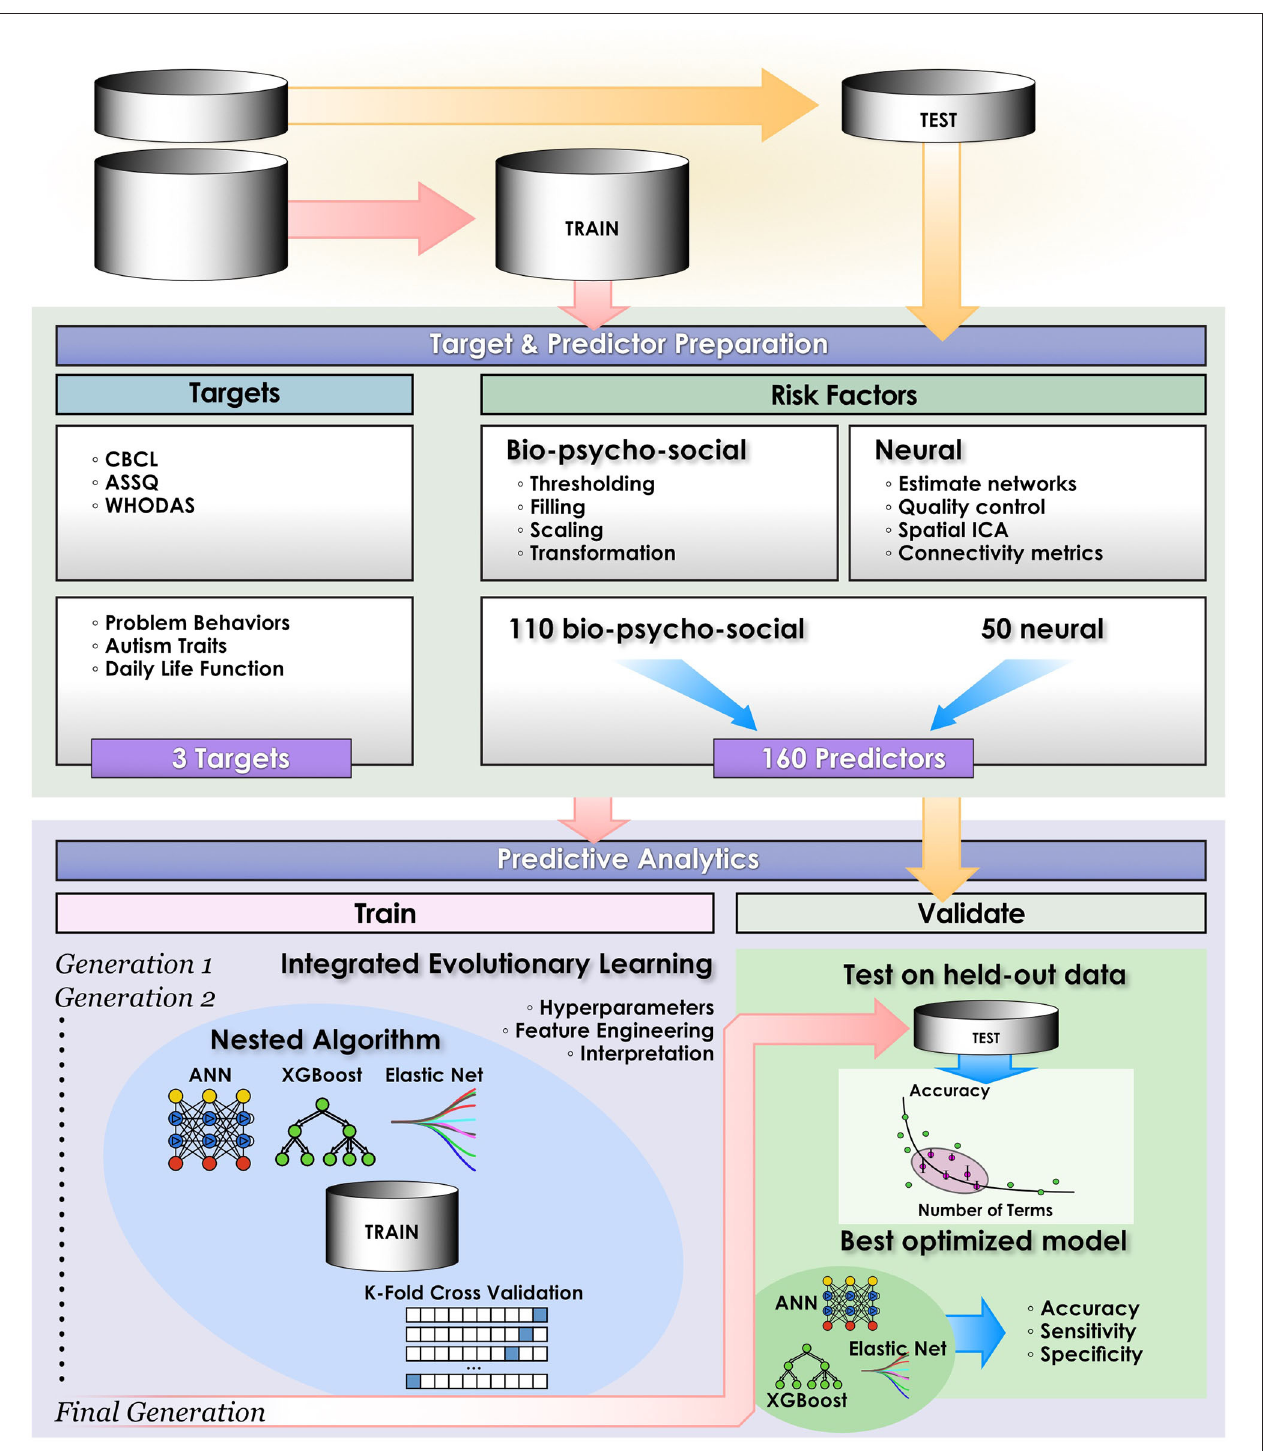
FIGURE 2 | Computational pipeline. The study computational pipeline is shown as detailed in materials and methods for classification experiments. In regression experiments the pipeline was similar, with the exceptions that only deep learning with artificial neural networks was performed and performance statistics of Mean Squared Error, Explained Variance and R 2 were